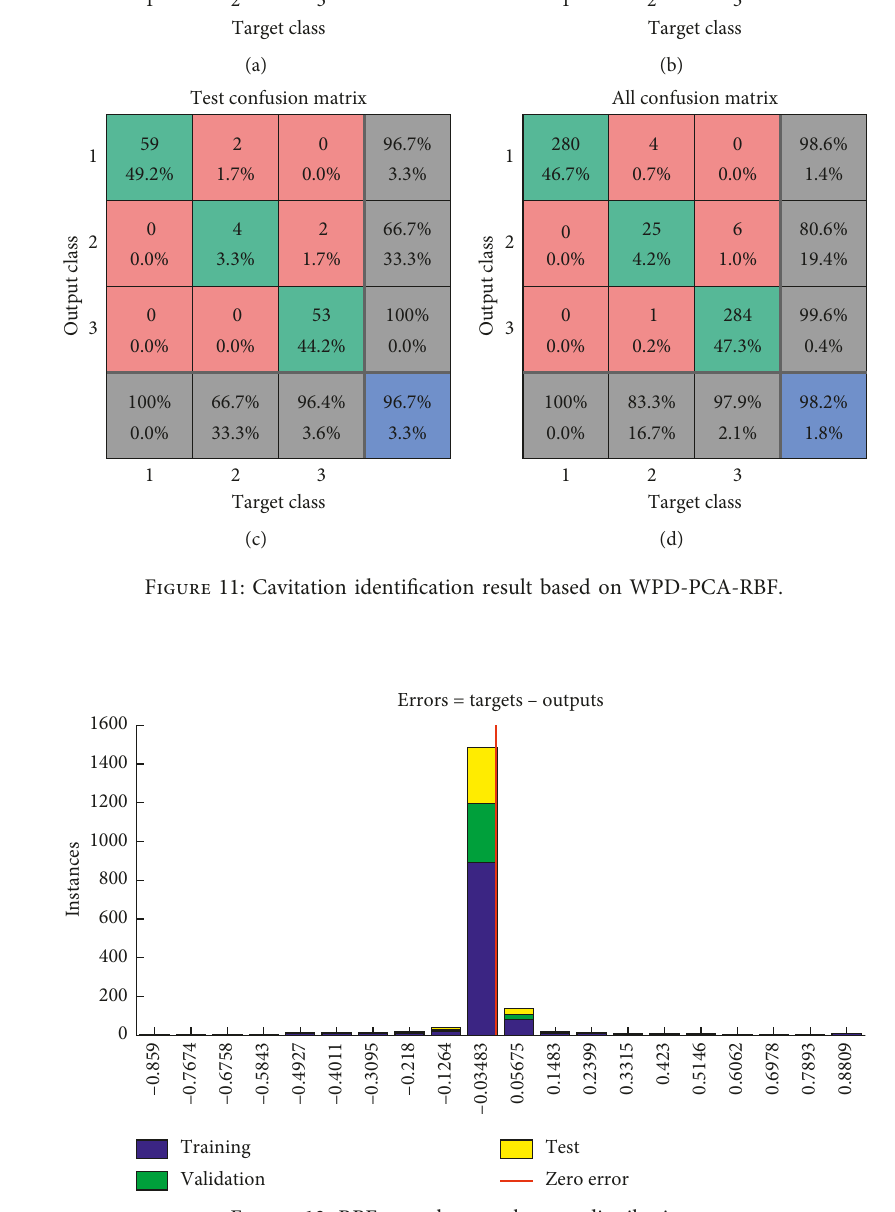
Figure 12: RBF neural network error